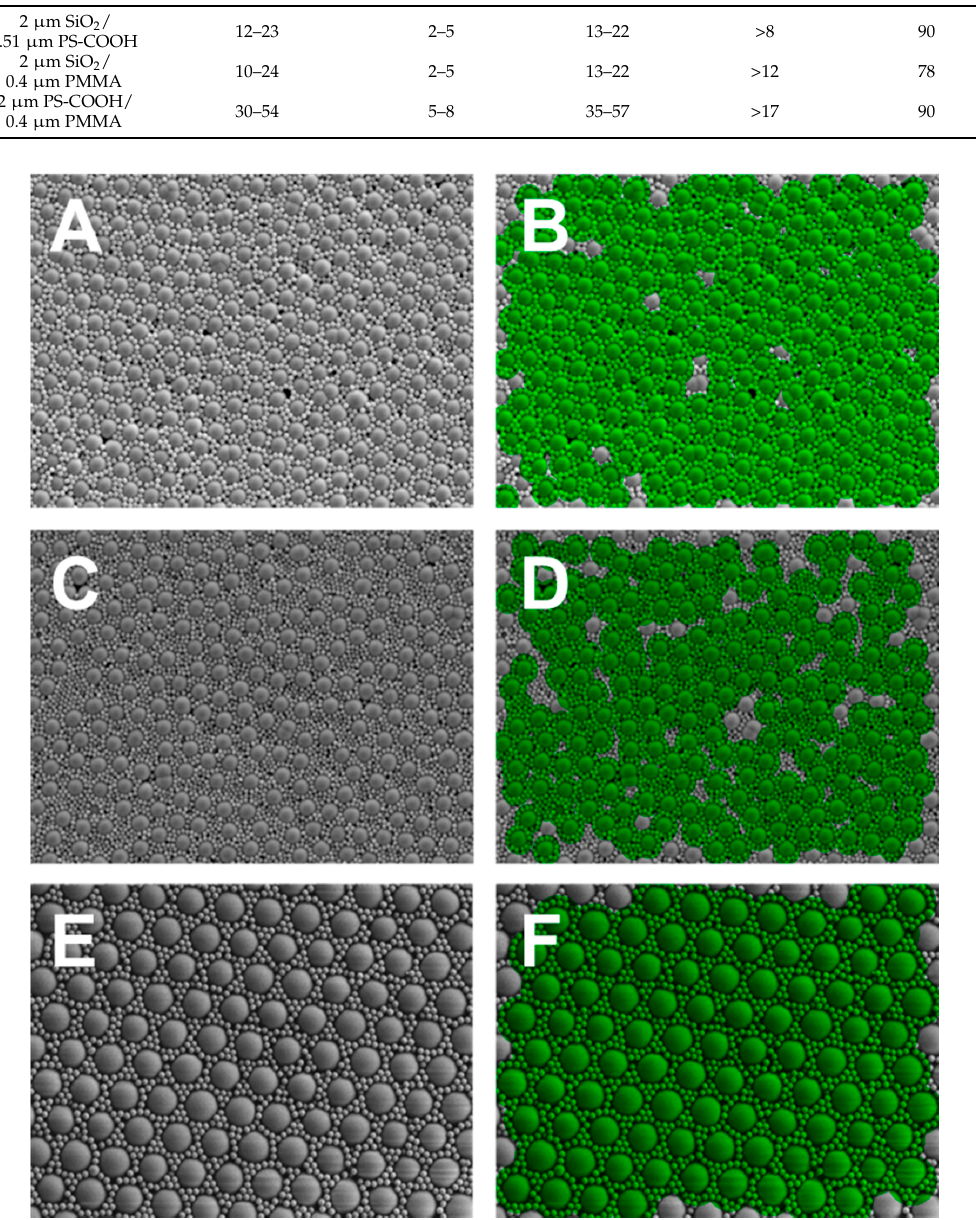
Figure 6. Selected SEM images of different BCCs with the first column ( A , C , E ) showing the original images and the second column ( B , D , F ) the processed images. The green areas represent highly uniform regions within the BCCs; ( A , B ) a BCC of 2 µm SiO 2 /0.51 µm PS-COOH particles where the detected degree of uniformity is 90%; ( C , D ) a BCC consisting of 2 µm SiO 2 /0.4 µm PMMA particles where the respective uniformity is 78%; ( E , F ) a BCC of 2 µm PS-COOH/0.4 µm PMMA particles where the uniformity equals 90%.